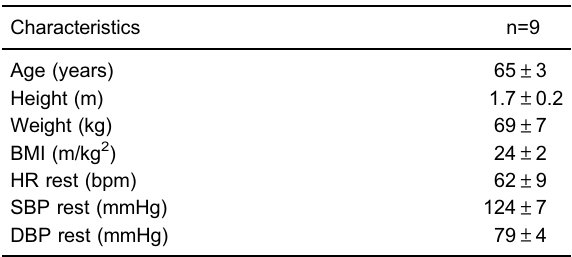
Table 1. Anthropometric and clinical characteristics of the study population.